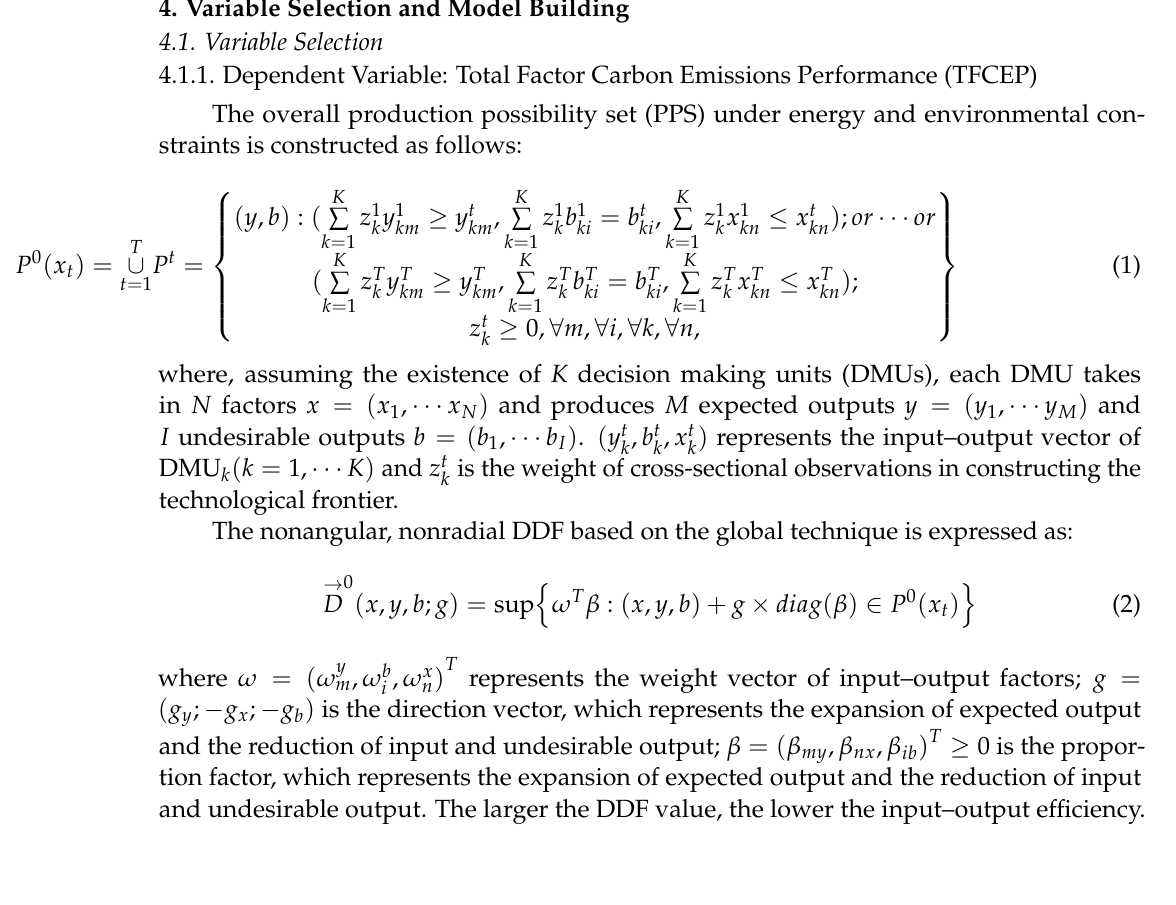
Figure 1. Diagram of the influence mechanism of GC and TFCEP.